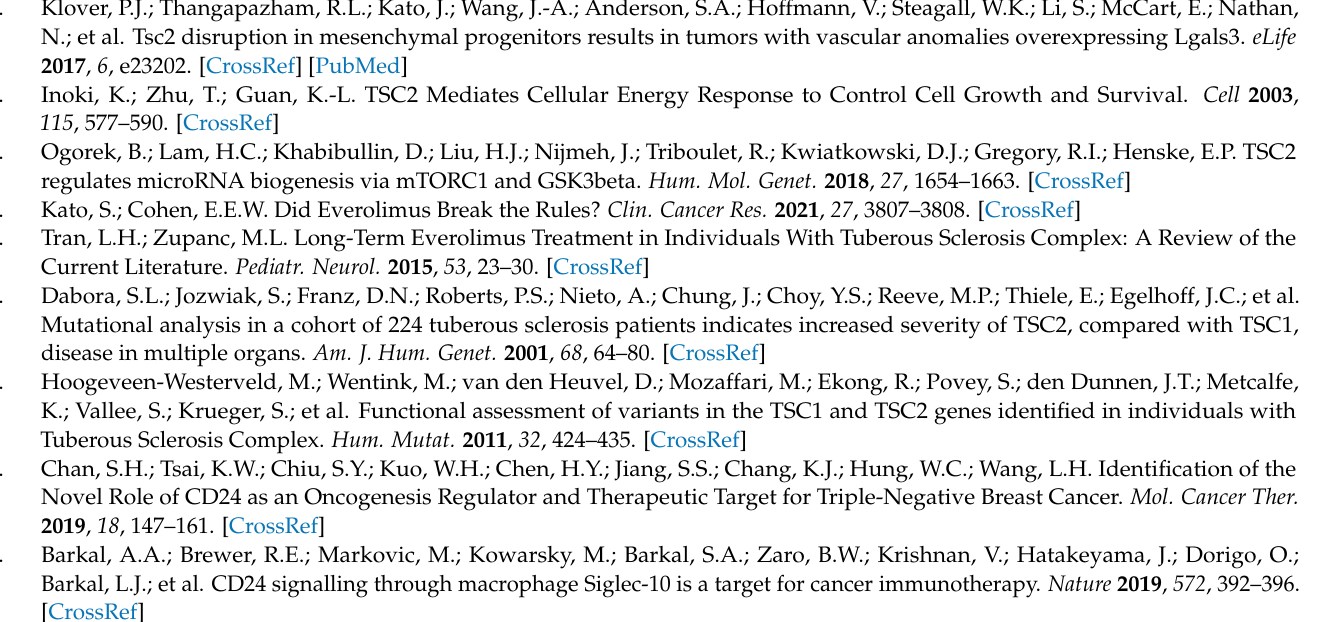
Figure S3: ChIP PCR of CD24 promoter region designed for this study; Figure S4: Gefitinib used